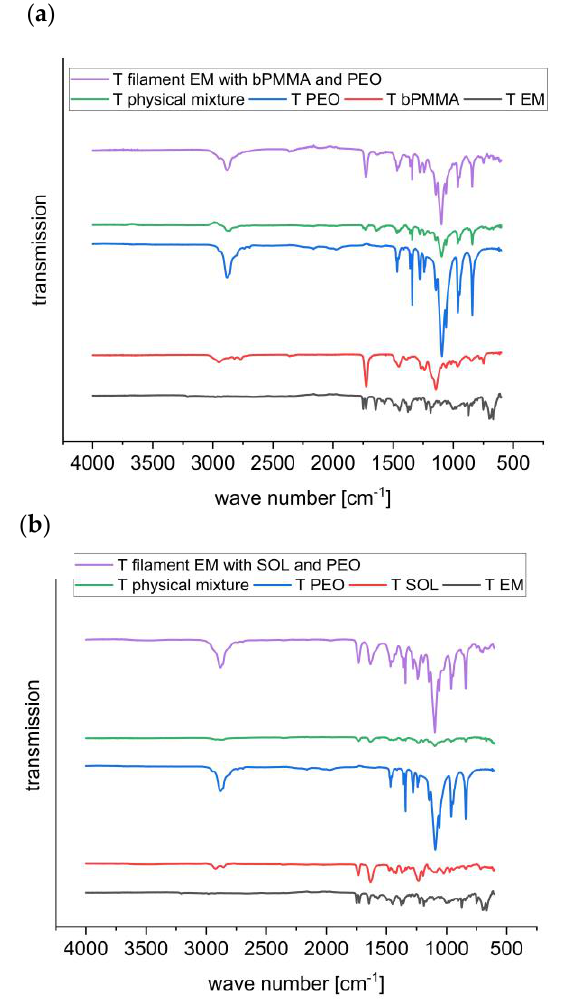
Figure 11. FT-IR spectra for formulations 5 ( a ) and 6 ( b ).